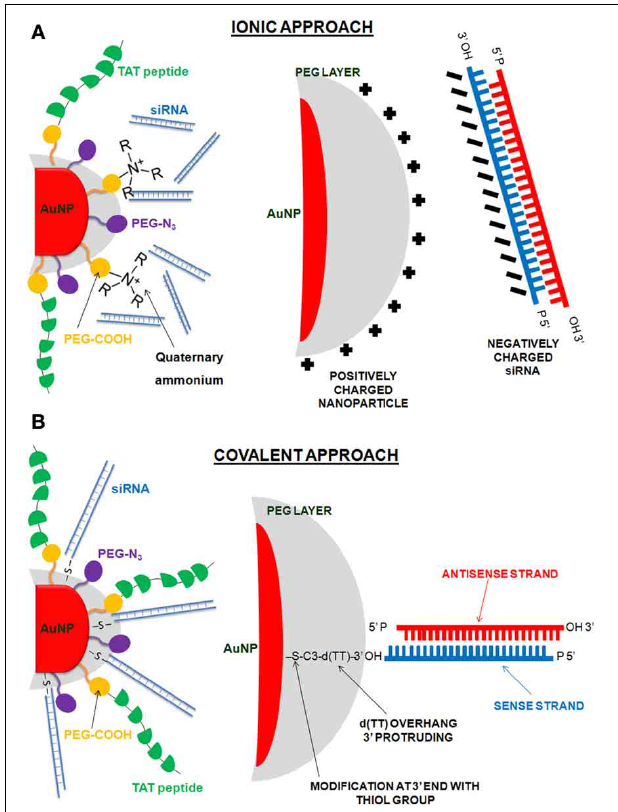
FIGURE 5 | Gold nanoparticles functionalized with multiple biomolecules: PEG, cell penetration peptide (TAT), ammonium quaternary groups, and siRNA. Two different approaches were employed to conjugate the siRNA to the AuNPs: (A) ionic approach, interaction of the negatively charged siRNA to the modified surface of the AuNPs through ionic interactions; (B) covalent approach, use of thiolated siRNA for gold thiol binding to the